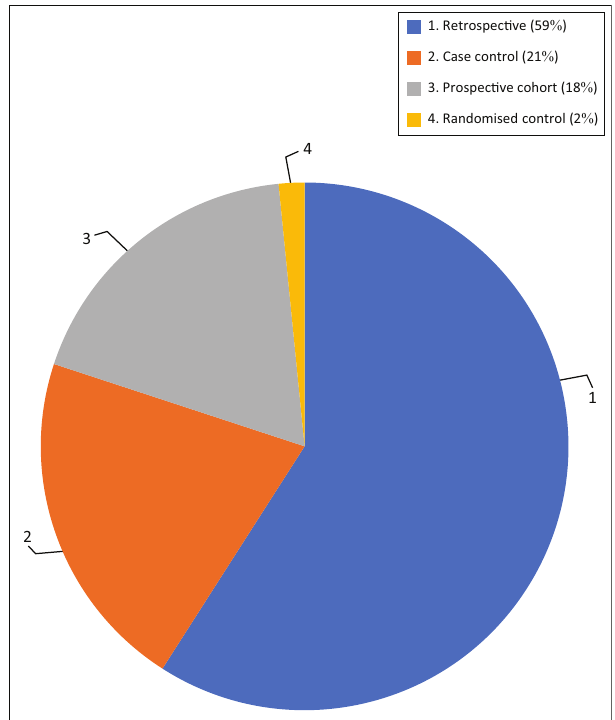
FIGURE 3: Study methodology employed in oesophageal cancer research in South Africa ( N =